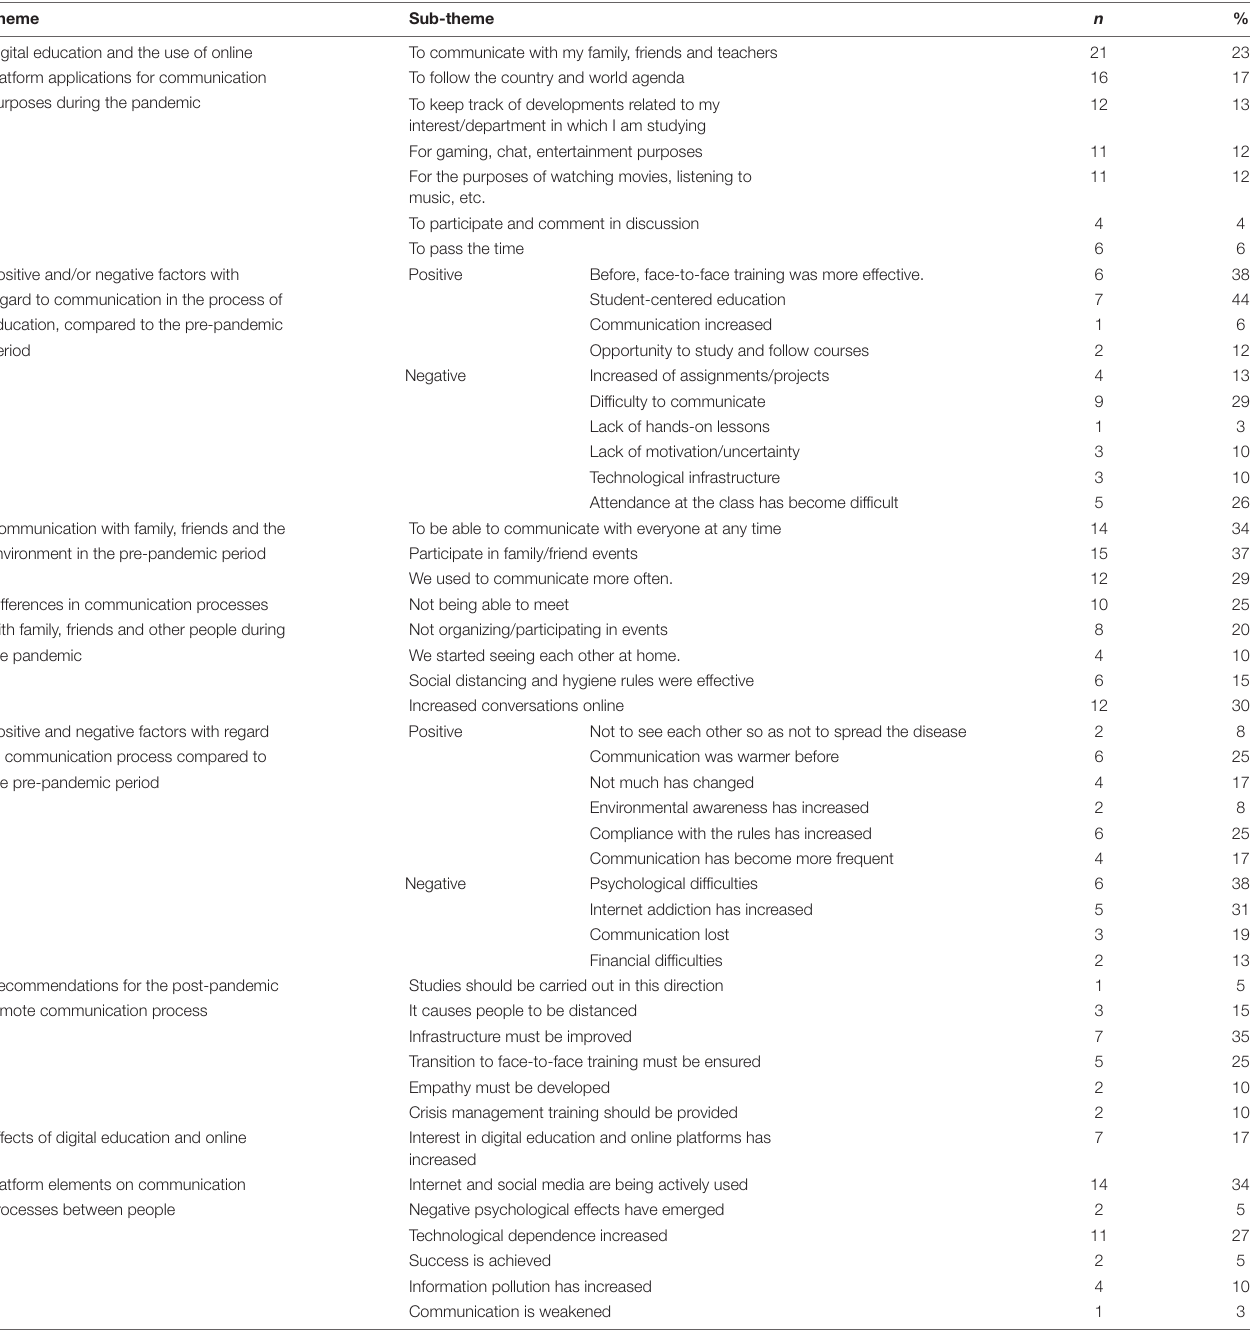
TABLE 2 | Digital literacy in distance education given during COVID-19; student opinions on communication-based